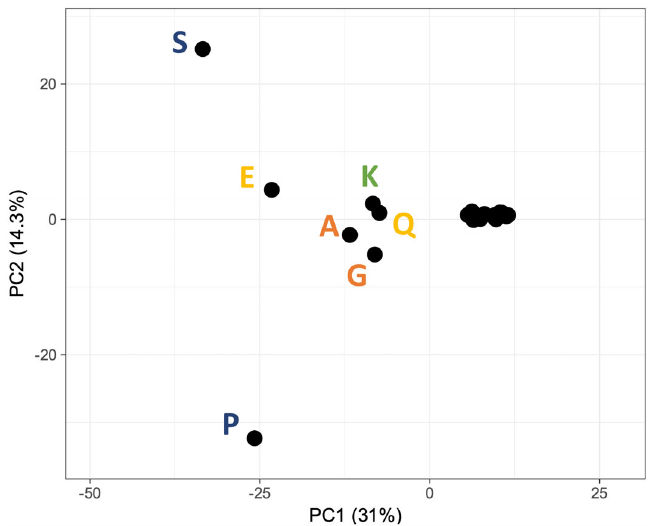
Figure 2. PCA analysis of DOID correlation to proteins with low complexity regions, across the human genome. The colour coding of each amino acid is the same as Figure 1 and reflects the chemical nature of their side chains. DOID=Disease Ontology